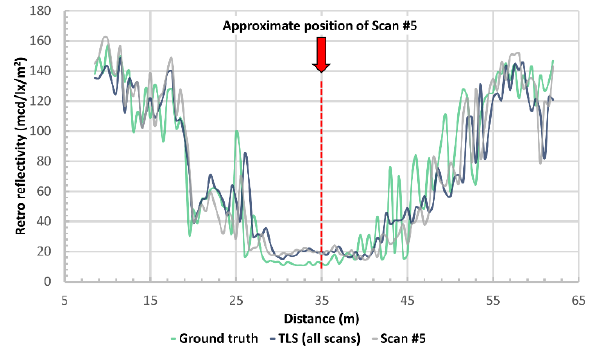
Figure 11. Comparison of retroreflectivity estimation using the points from a single scan and all scans